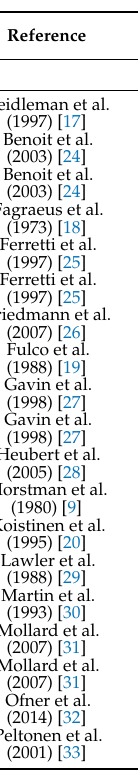
Table 1. Characteristics of the studies included in the